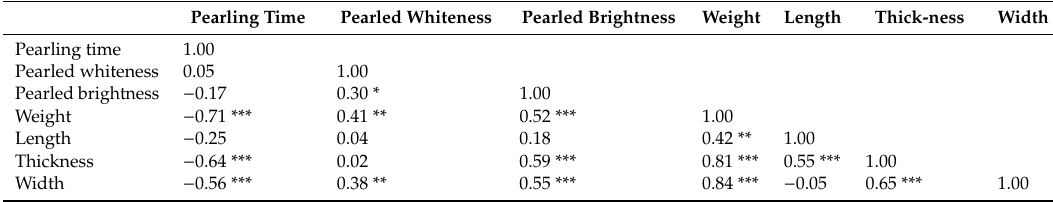
Table 2. Correlation coe ffi cients among grain characteristics used to predict its e ff ect on barley pearling. Pearling Time Pearled Whiteness Pearled Brightness Weight Length Thick-ness Width Pearling